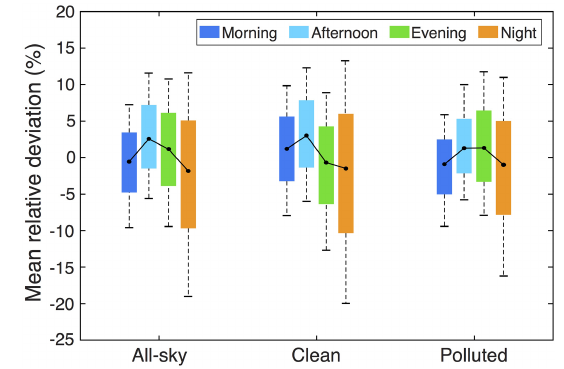
Figure 5. Impacts of diurnal phases of missing values on PM 2 . 5 daily averages. Hourly PM 2 . 5 values in the morning (07:00–11:00CST), afternoon (12:00–16:00CST), evening (17:00– 21:00CST), and night (22:00–06:00CST) were removed from the original hourly PM 2 . 5 time series throughout the day to resemble missing values. On each box, the black dots represent medians of mean relative deviations, while the bottom and top edges of the box indicate the 25th and 75th percentiles, respectively, and the bottom and top whiskers extend to the 10th and 90th percentiles, respec-